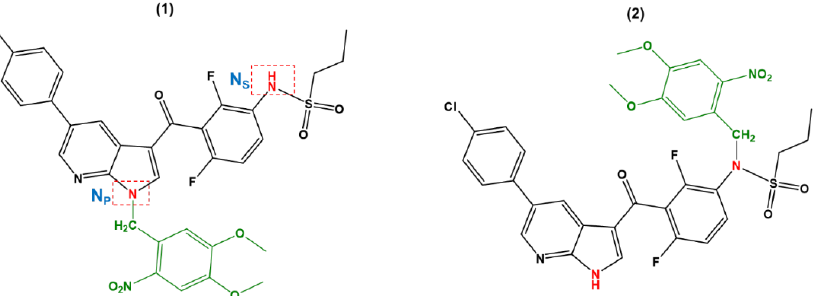
Figure 2. Chemical structures of the DMNB-photocaged VFB pyrrole (N P ) and sulfonamide (N S ) amine groups considered in this work.